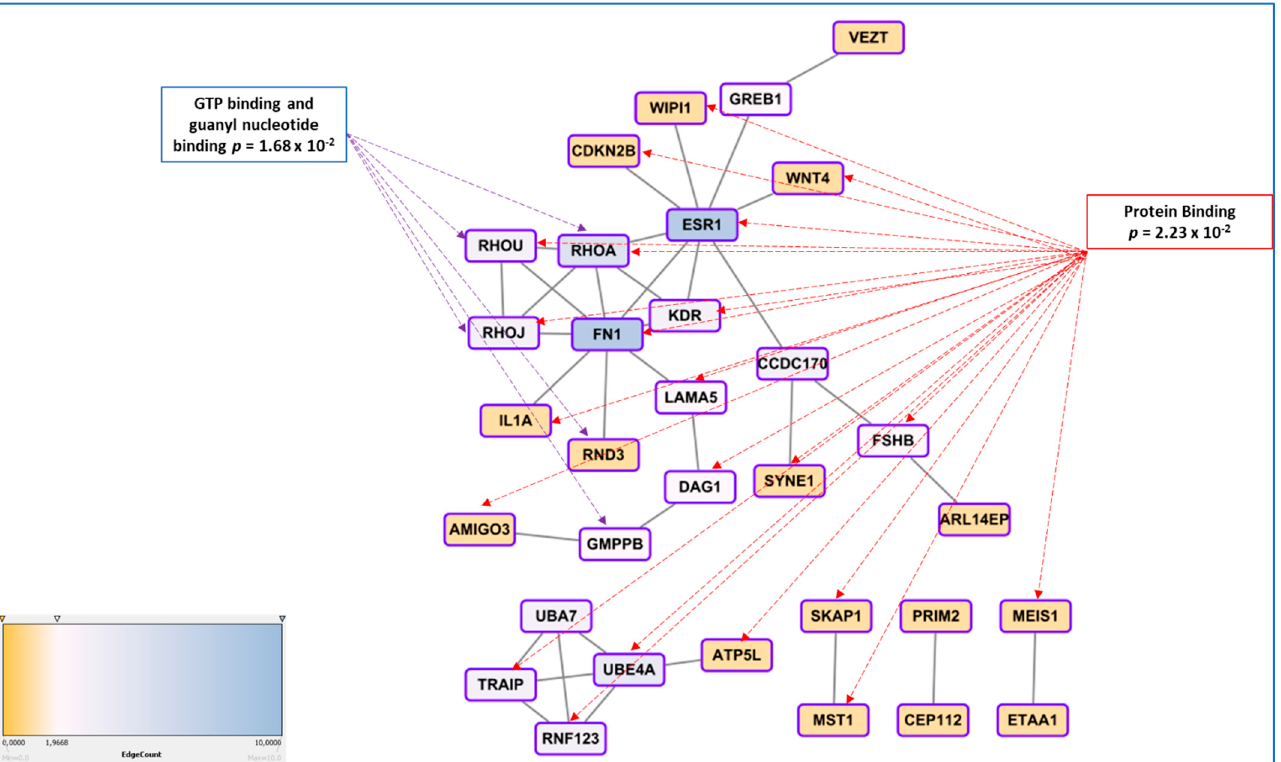
Figure 2. A significantly enriched gene network is constructed from the list of genes found through GWAS approaches using the online tools STRING and Cytoscape, that allowed to identify hubs (genes with the highest degree of connection, ESR1 and FN1). Functional annotation using BINGO led to discover the most enriched molecular functions, connected to GTP metabolism and Protein binding, in a broad sense. The Edge count associated with the color is proportional to the number of links connecting the different genes.